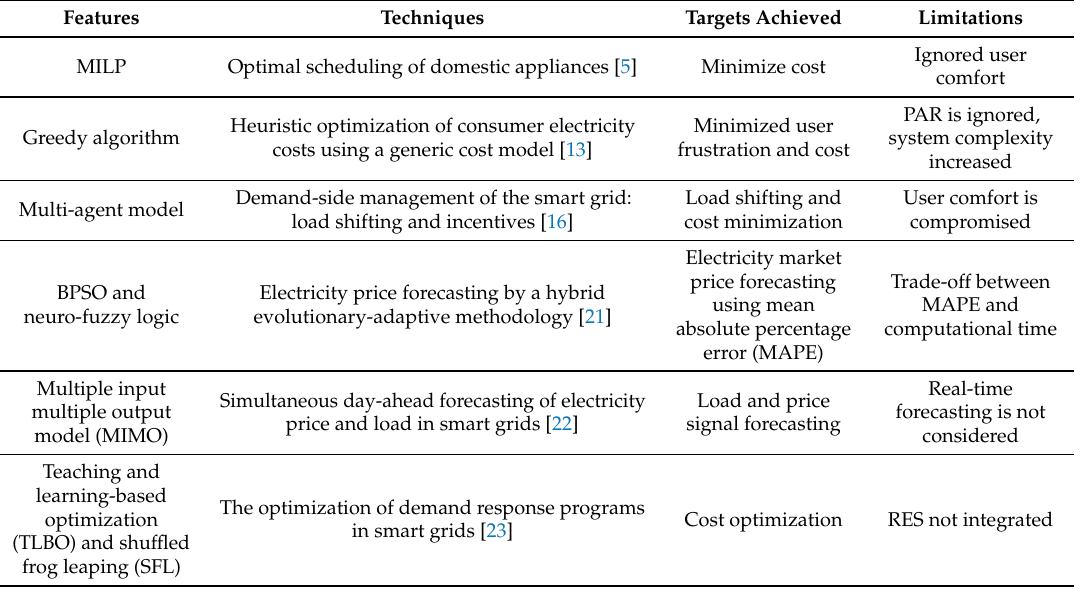
Table 3. Summarized related